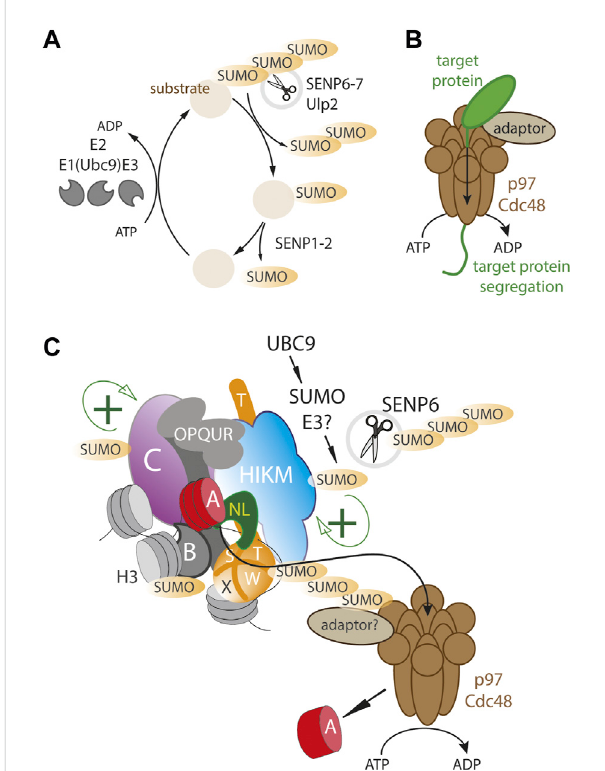
FIGURE 1 A dynamic SUMO balance maintains centromere homeostasis. (A) Basic outline of SUMO cycle where substrates are mono- and polySUMOylated by SUMO-speci fi c E3 ligases in conjunction with the Ubc9 E2 ligase. SENPs deSUMOylate where SENP6-7/ Ulp2 remove preferentially polySUMO chains (B) the VCP/p97/ Cdc48 segregase is an ATP dependent motor protein complex that can physically remove proteins from protein assemblies and stable subcellular compartments (C) The human centromere complex (CCAN) is SUMOylated at multiple sites (including CENP-C, -B, -T, -H, -I -K), possibly facilitating complex formation and stability (green+). Excessive SUMOylation results in a p97/Cdc48 dependent removal of the CCAN as well as CENP-A. SENP6/Ulp2 counteracts p97/Cdc48 by continuously removing polySUMO